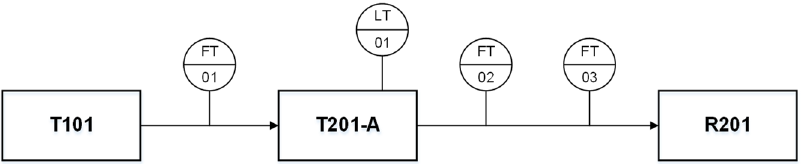
Figure 11. Schematic representation of the main equipment and instrumentation involved in the feeding of reactant D to R201.